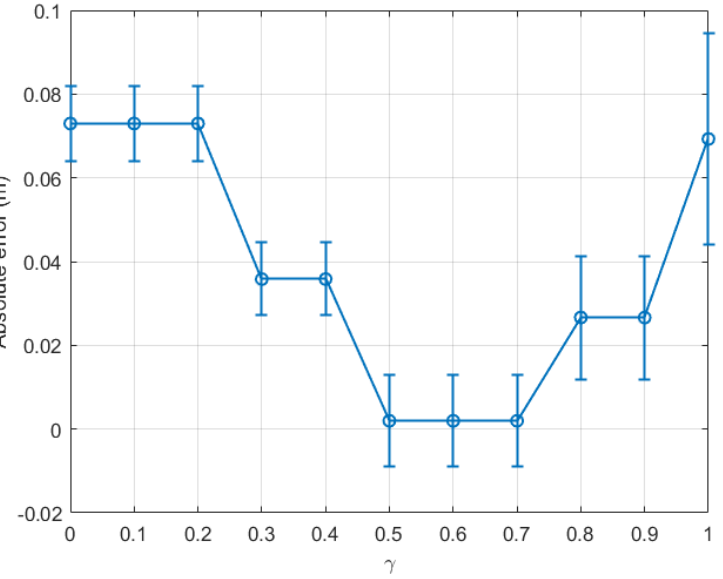
Figure 9. Outdoor walking (dataset 3): absolute error of the last time window ( tw 15 ) with respect to γ ∈ [ 0,1 ] .